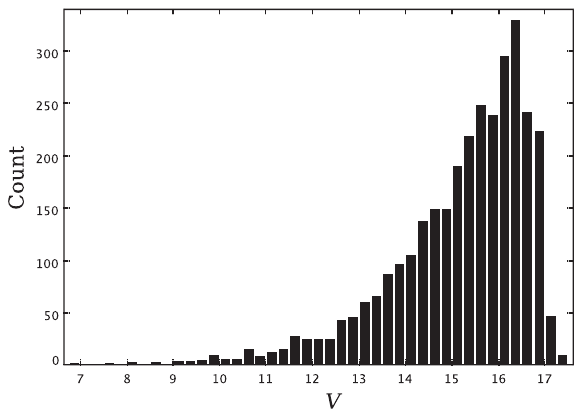
Fig. 3. Distribution of all measured stars in apparent